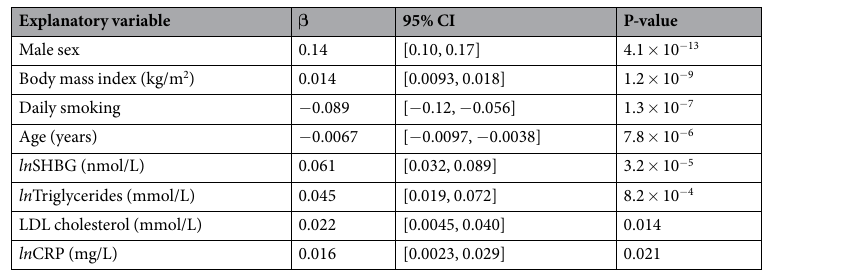
Table 2. Cross-sectional stepwise multivariable linear regression modelling for homoarginine (hArg) (n = 2057). Statistics: In the bi-directional stepwise regression modelling applied, serum hArg was used as a dependent variable and all the variables shown in Table 1 and ln SHBG as explanatory variables. Those variables that were selected by Akaike’s information criterion (AIC) using the stepAIC R function with the default settings and had a p-value < 0.05 are shown above. HArg, SHBG, triglycerides and CRP were natural log-transformed. For the continuous variables, β (95% CI) are shown for each 1‐unit change in the